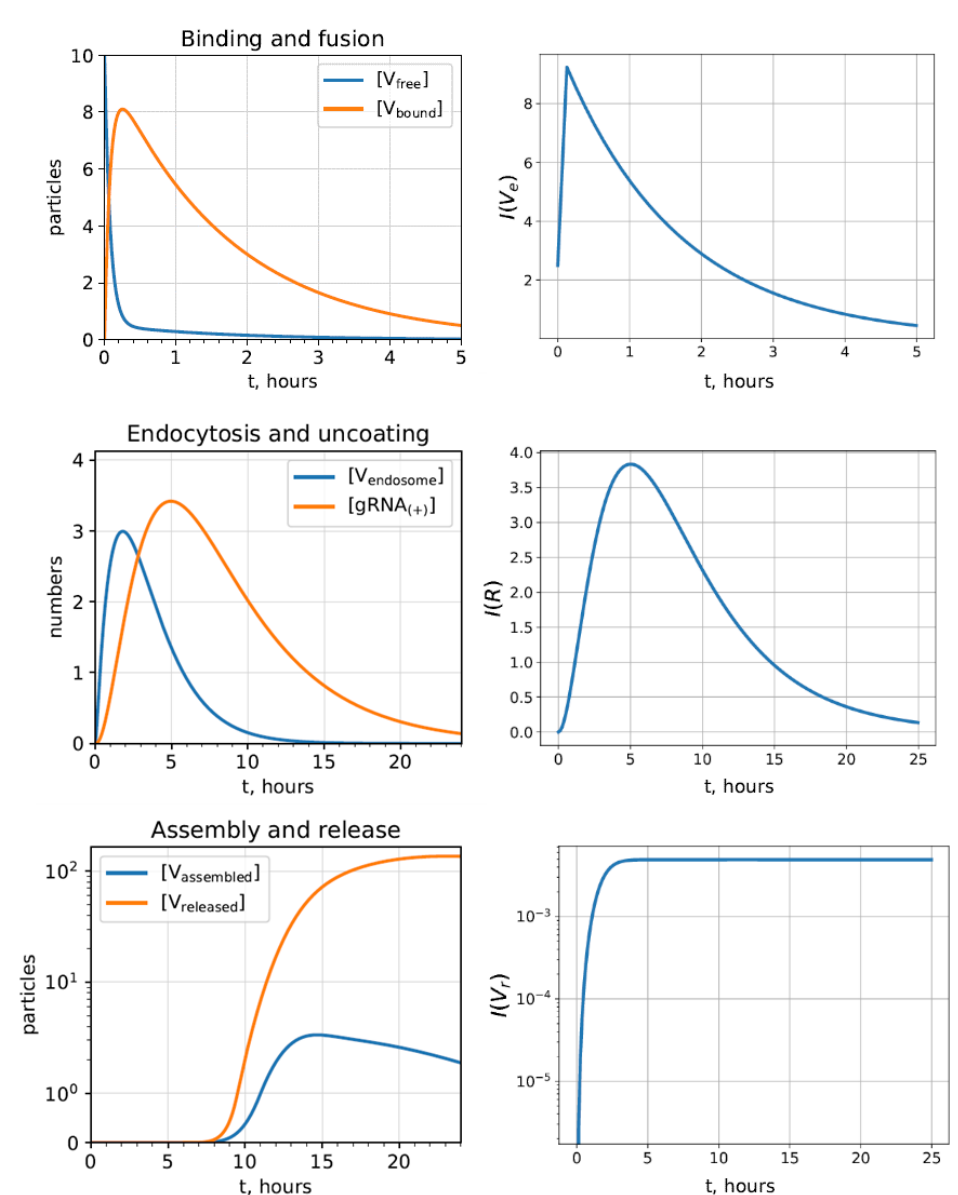
Figure 5. Comparison of the kinetics of SARS-CoV-2 replication predicted by model (1)–(5) (right) with results from ([21], Figure 2) (left). The values of parameters are estimated from the